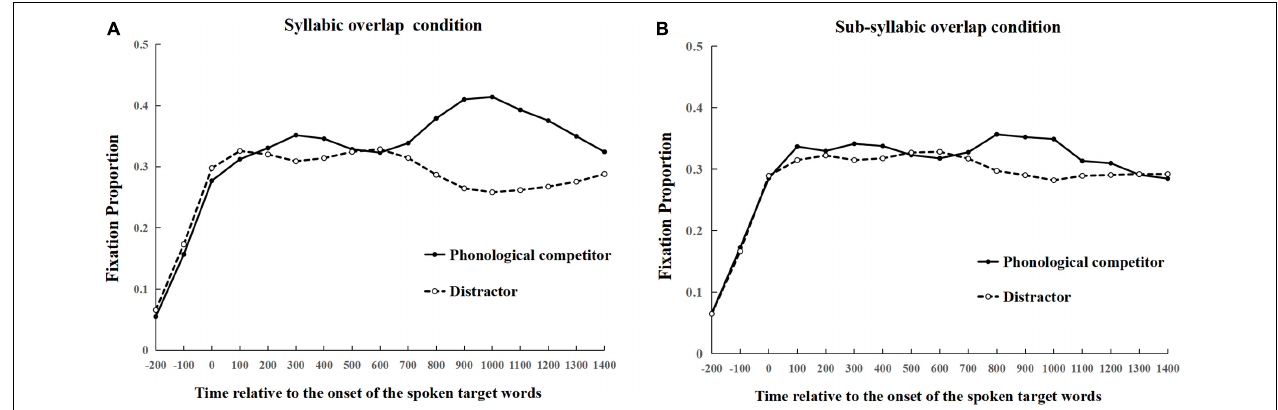
FIGURE 4 | Proportion of fixations on the phonological competitor and the distractors from 200 ms before the onset of the spoken target word in syllabic overlap condition (A) , and sub-syllabic overlap condition (B) , respectively in Experiment 2.